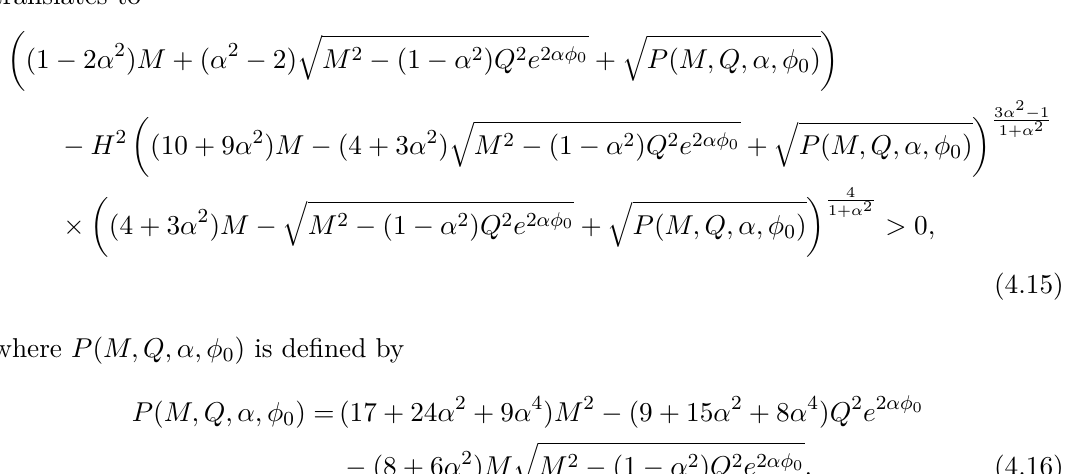
JHEP11(2021)058